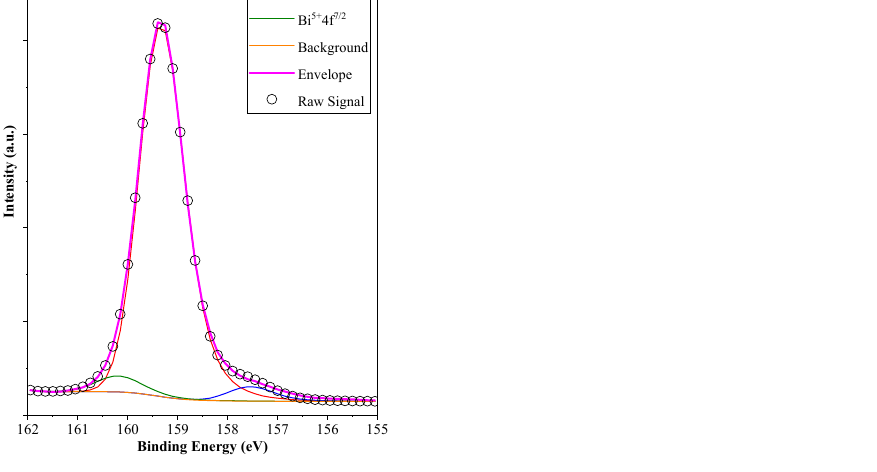
Figure 7. Bi4f 7/2 XPS spectrum of sample BiOCl_PVP, showing both reduced and oxidized bismuth species.